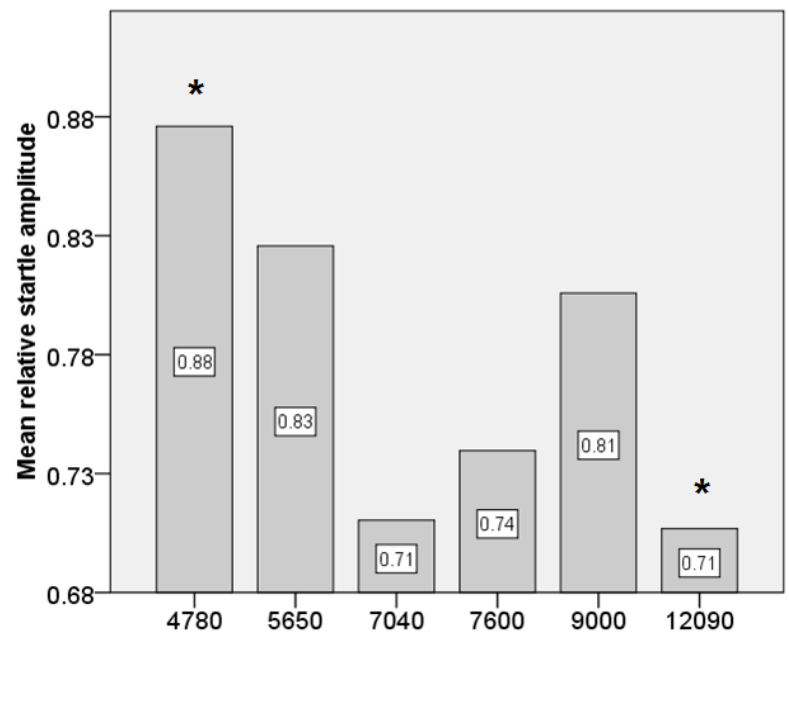
Figure 1. Mean relative startle amplitudes for all six areas with different median real estate prices per m 2 . All means are calculated relative to their corresponding baselines. The lowest startle amplitude in the highest price condition differs significantly from the highest startle amplitude in the lowest price condition. This reflects the most positive emotional and motivational state while walking through the most expensive urban environment. Note that the second most expensive urban environment is associated with a higher startle amplitude than two cheaper urban